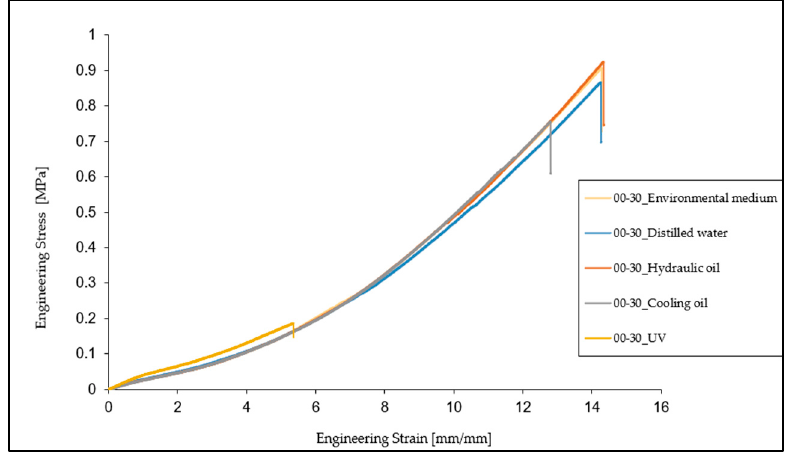
Figure 3. Engineering stress vs. engineering strain curves for Ecoflex 00-30 in the five different environments.